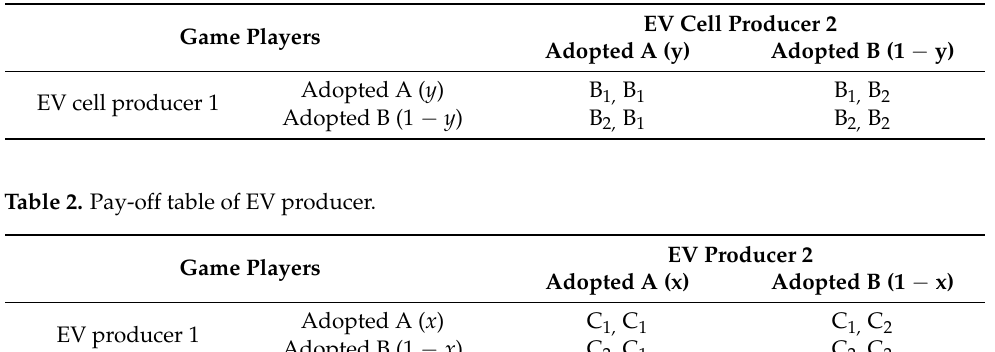
Table 1. Pay-off table of EV cell producer.